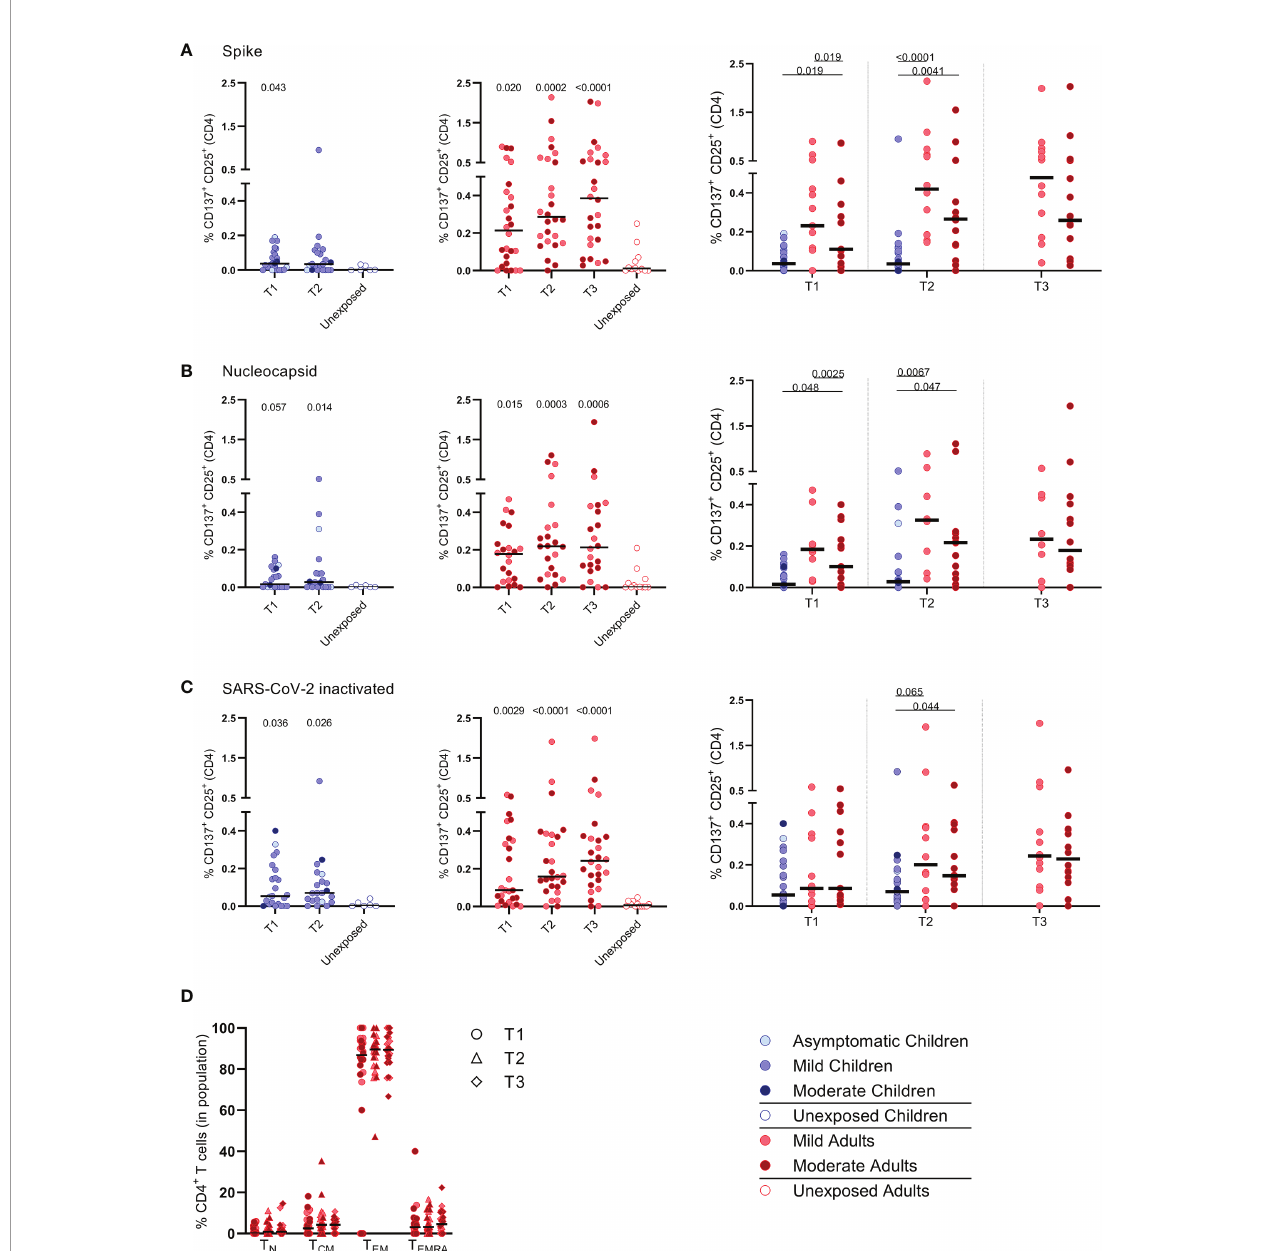
FIGURE 2 | Frequencies of activated CD4+ T cells of infected children and infected adults (mild and moderate cases) versus unexposed healthy controls over time after infection. Dot plots summarizing the percentages of CD25+/CD137+ activated CD4+ T cells responding to SARS-CoV-2 antigens for (A – D) children (left panel, blue), adults (middle panel, red), and children versus mild and moderate adult cases separately (right panel). Percentages of CD25+/CD137+ activated CD4+ T cells responding to (A) set of overlapping peptides of SARS-CoV-2 spike protein, (B) set of overlapping peptides of SARS-CoV-2 nucleocapsid, (C) inactivated SARS- CoV-2. (D) Immunophenotyping at the single-cell level showing the different memory subsets within the SARS-CoV-2-speci fi c activated CD4+ T cells from infected adults. Each dot represents one subject. Bars indicate the median percentage of total CD4+ T cells. (A – C) P values related to comparisons with the unexposed controls are listed at the top of the graph, above the corresponding group for comparison. For unpaired comparisons, Mann-Whitney U test (two-group comparisons) (mild adults versus moderate adults) or Kruskal-Wallis rank-sum test with Dunn ’ s post hoc test for multiple comparisons were used (children versus mild adults versus moderate adults; unexposed versus infected children or adults at T1 versus T2 versus T3). Differences between paired data were compared using the Wilcoxon signed-rank test (for comparison of two paired groups) (infected children at T1 versus T2) or the Friedman test with Dunn ’ s multiple comparison tests (infected adults at T1 versus T2 versus T3). Statistically signi fi cant comparisons are indicated, with P values < 0.05 considered signi fi cant. T1, fi rst timepoint of sampling for adults median 12.5 days and children median 8 days post-symptom onset; T2, 10-14 days after T1; T3, 4-6 weeks after